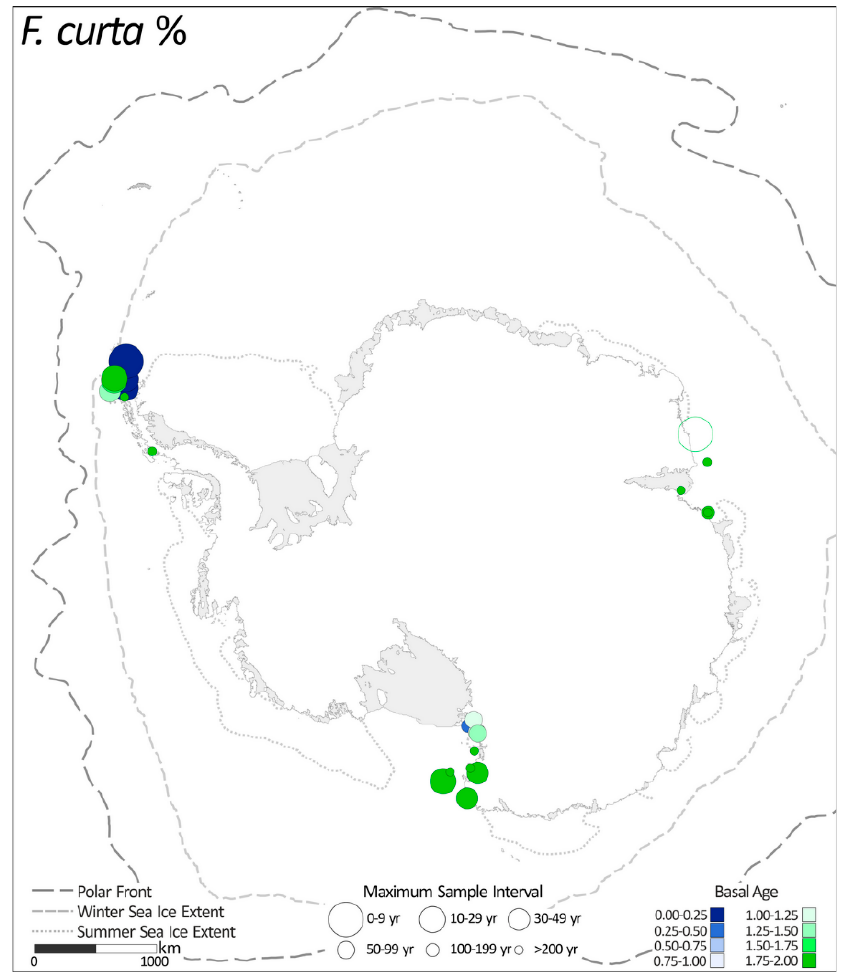
Figure 3. Map showing cores sites where F. curta % is used to reconstruct sea ice conditions. The symbol size reflects the resolution of the record and the color of the symbol indicates the basal age of the record between 0 and 2 ka BP. The hollow circle symbols are used for discrete and/or discontinuous records from laminated sediments to illustrate the resolution only.